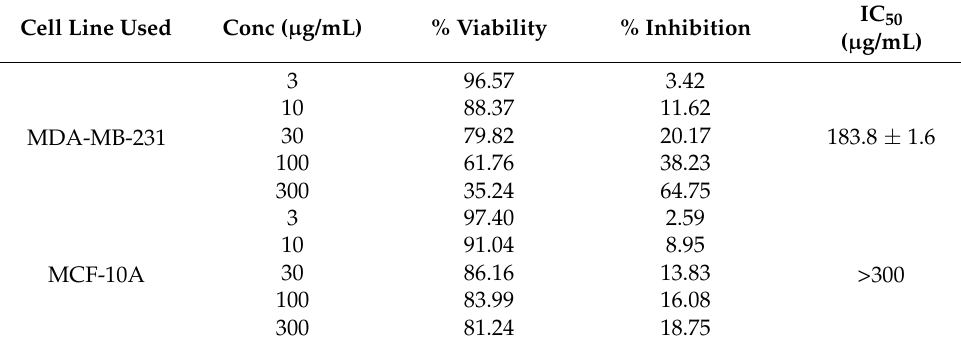
Table 2. Cytotoxic significance of ELEO.